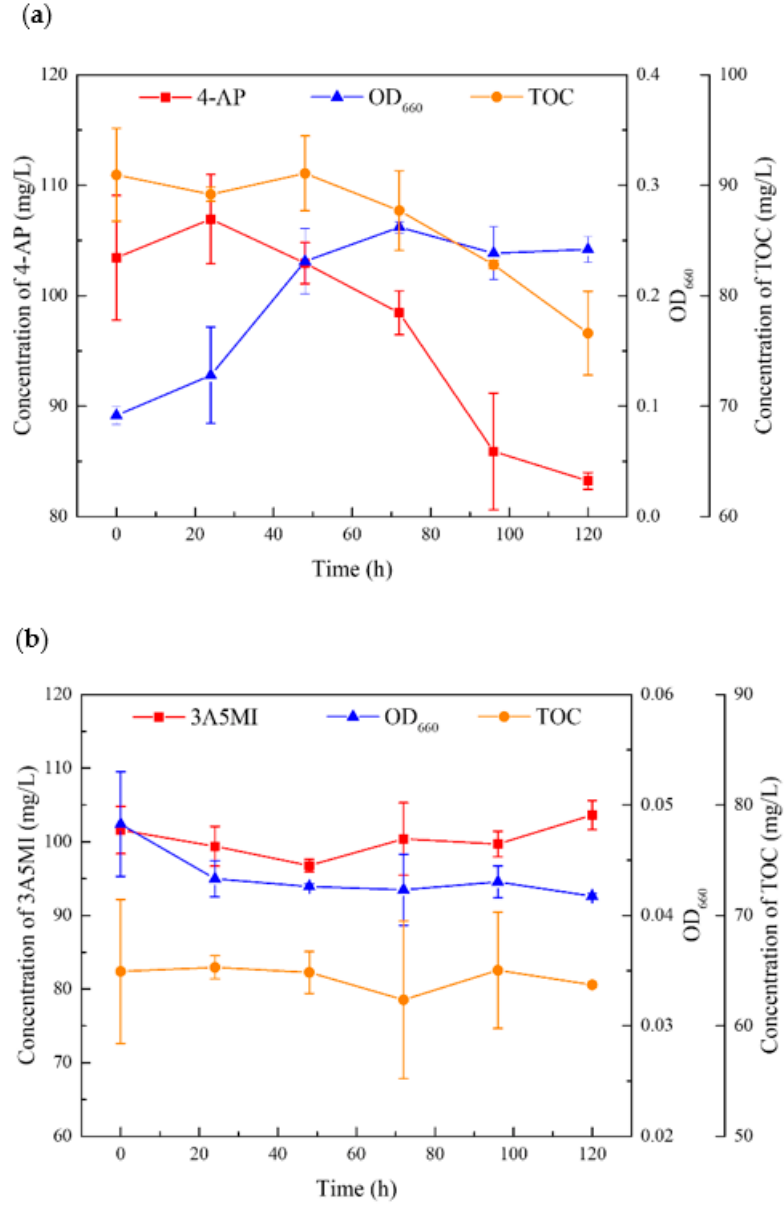
Figure 5. The ability of YL2 to utilize SMX degradation products: ( a ) Growth of strain YL2 on 4-aminophenol and the corresponding biodegradation with time; ( b ) Growth of strain YL2 on 3-amino-5-methylisoxazole and the corresponding biodegradation with time.